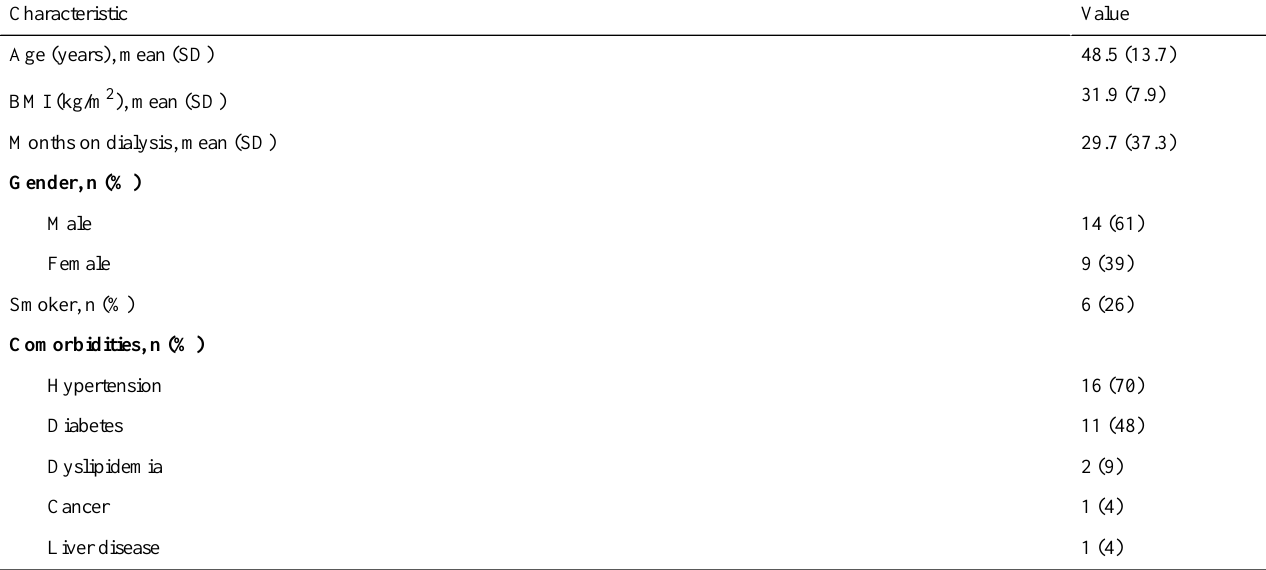
Table 1. Demographics and baseline characteristics of the study population